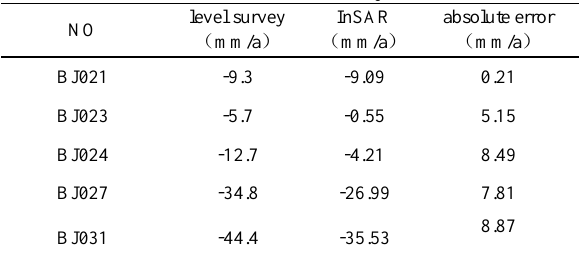
Table 1. InSAR Result Accuracy Verification